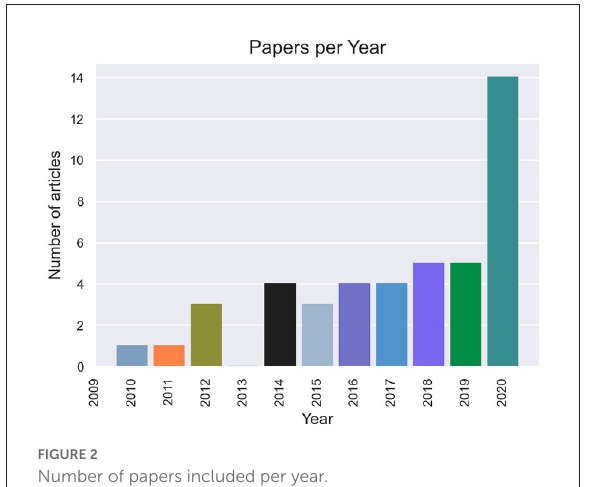
FIGURE2 Number of papers included per